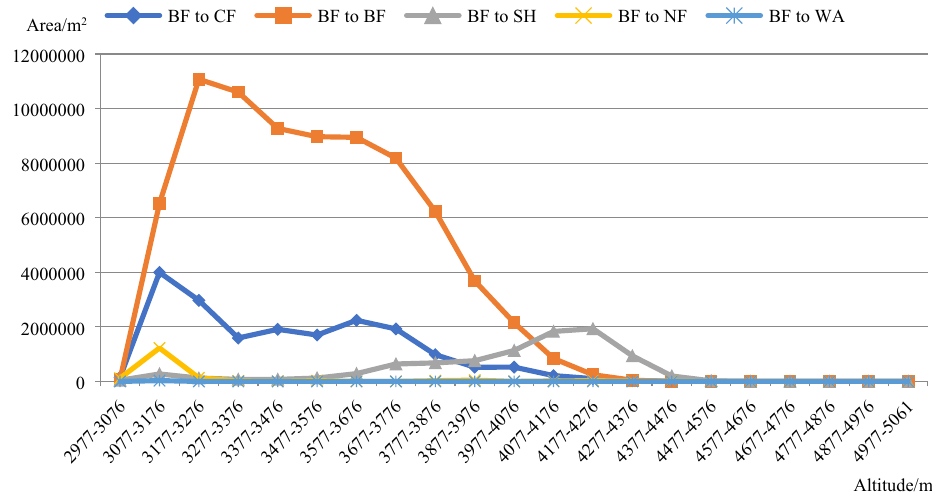
Figure 6. Distribution of the changed and unchanged CF areas in the 21 altitude gradients between 2013 and 2015. The figure is generated using the Microsoft Office 2016 (http:// www. office.